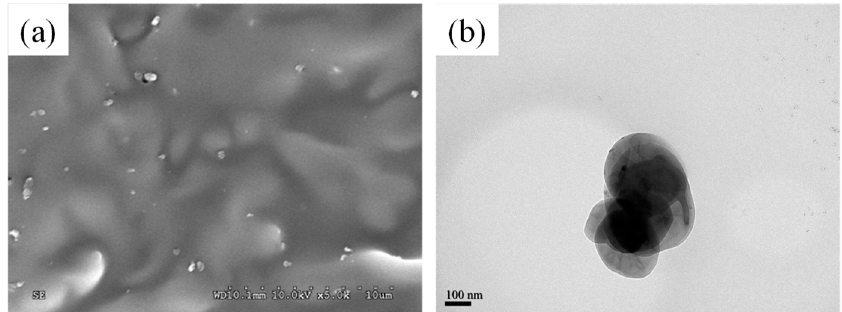
Figure 3. ( a ) Scanning electron microscopy (SEM); ( b ) Transmission electron microscopy (TEM) image of PLLA/PEA/h-BN = 99/1/0.5 composite.